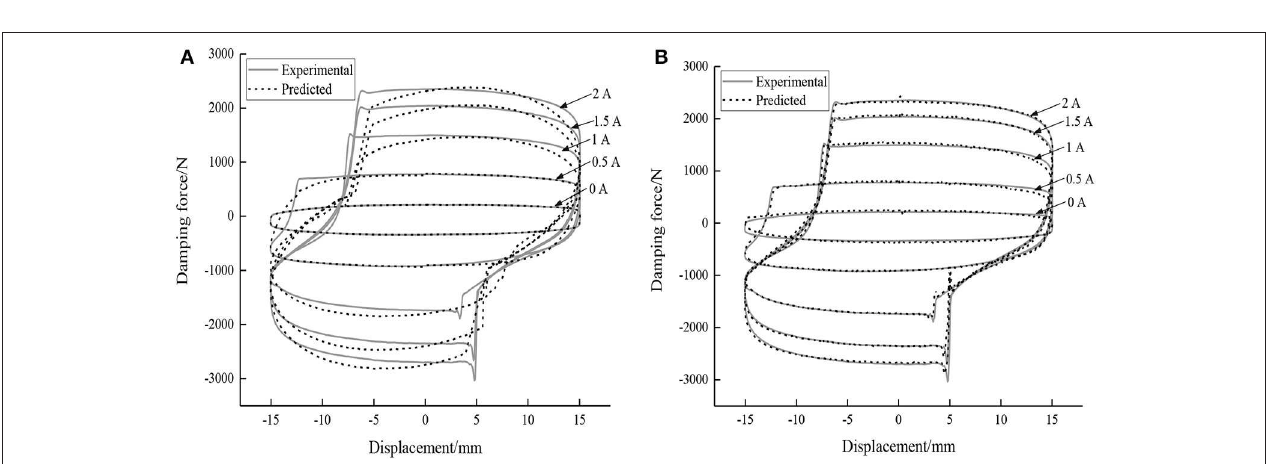
FIGURE 10 | Comparisons between the measured and predicted results for other two models. (A) Algebraic model. (B) Back propagation (BP) neural network model.